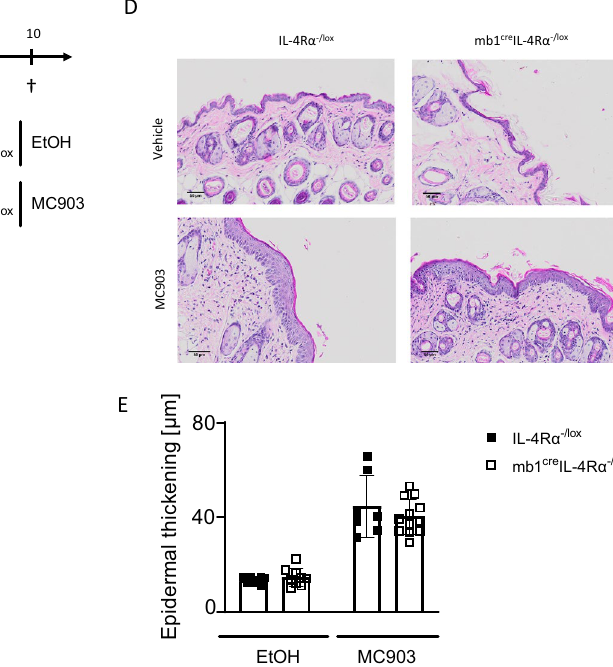
Figure 5. IL-4R ⍺ responsiveness in B cells is not essential in acute MC903-induced epidermal thickening but is required for IgE production. (A) Mice were shaved 3 days prior to topical treatment with either Ethanol or 45 µM MC903 for 9 consecutive days. ( B ) Weight loss in IL-4R ⍺ −/lox and mb1 cre IL-4R ⍺ −/lox treated with EtOH and MC903. ( C ) Total IgE serum levels. ( D ) H&E-stained images showing epidermal thickening, scale bar 50 μm. ( E ) Quantification of epidermal thickening using QuPath software, Shown are pooled 2 independent experiments with mean ± SEM. Statistical analysis was performed using the Student t-test Mann–Whitney where ****p > 0.0001 between littermate IL-4Rα –/lox group vs iLCK cre IL-4Rα –/lox group treated with EtOH or MC903. n = 5–10 mice per